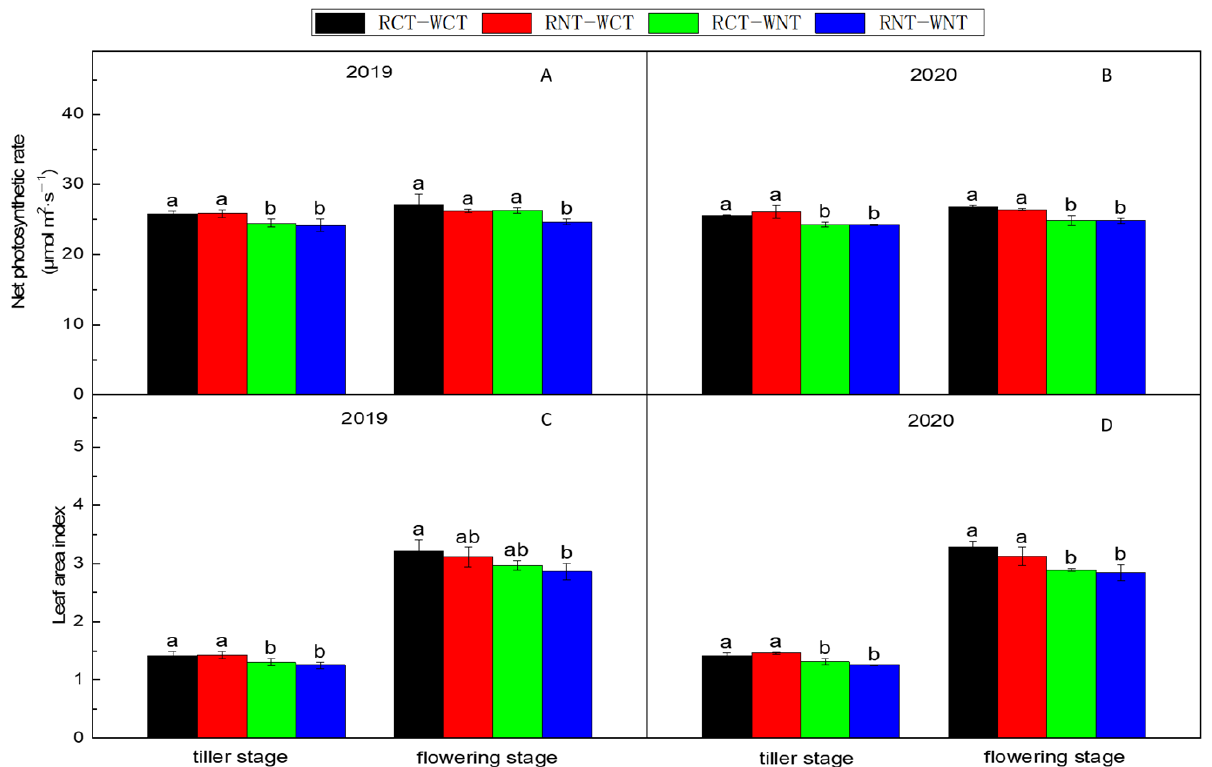
Figure 3. Net photosynthetic rate in 2019 ( A ) and 2020 ( B ) and leaf area index in 2019 ( C ) and 2020 ( D ) of rice under different tillage managements. RCT–WCT, conventional tillage before transplan ‐ tation/sowing of each crop; RNT–WCT, no tillage before transplantation of rice and conventional tillage before sowing of wheat; RCT–WNT, conventional tillage before transplantation of rice and no tillage before sowing of wheat; RNT–WNT, no tillage before sowing of each crop. Different low ‐ ercase letters indicate statistical differences among treatments at p < 0.05.